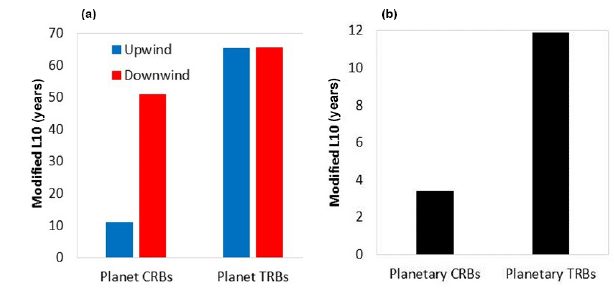
Figure 15. Fatigue life for the planet bearings (a) and planetary bearing stage (b)